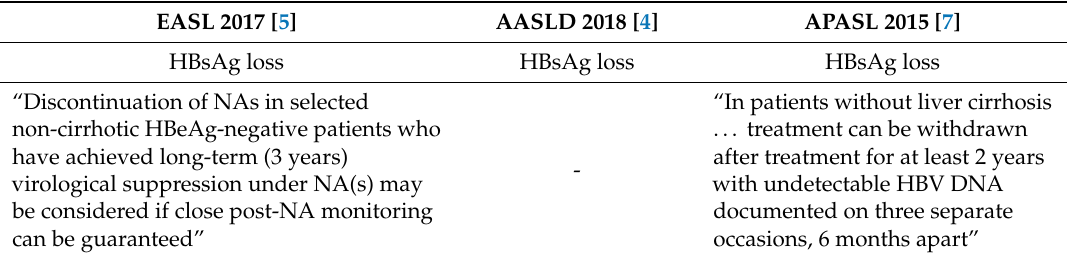
Table 2. Recommended endpoints for NA treatment in HBeAg-negative